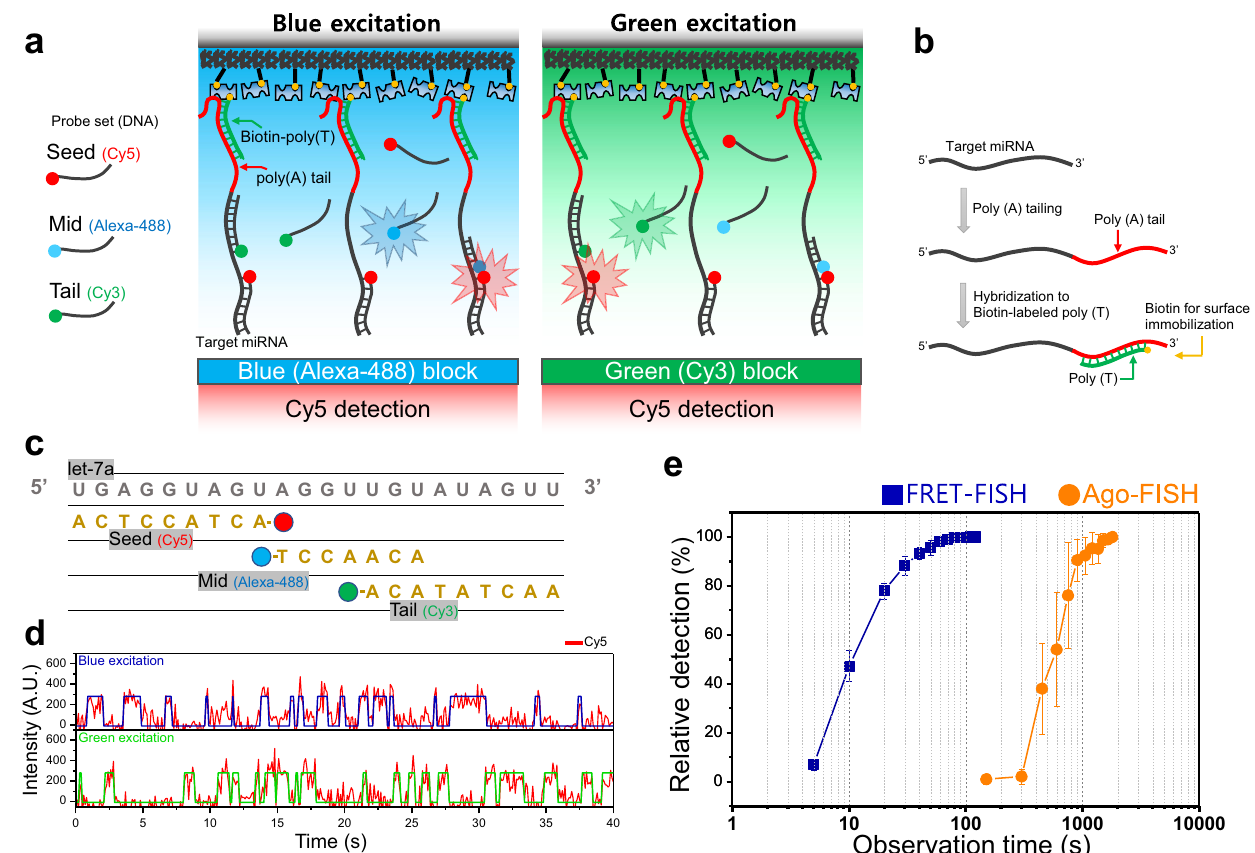
Fig. 1 miRNA detection using dynamic FRET-FISH. a Scheme of target miRNA detection. Only the acceptor signal is used for miRNA detection whereas only donor fl uorophores (Alexa-488 and Cy3) are excited. In this way, background acceptor fl uorescence coming from fl oating accepter strands is reduced because the acceptor signal is generated only when both donor and acceptor strands simultaneously bind to target miRNAs. b miRNA preparation. Puri fi ed RNA is hybridized with biotinylated poly (T) after poly (A) tailing. Then RNA is immobilized on a surface via biotin-streptavidin interaction. c Sequences of the target miRNA (let-7a), Cy5-labeled seed probe, Alexa-488-labeled mid probe, and Cy3-labeled tail probe. d Representative Cy5 fl uorescence intensity time traces (red) detected at Alexa-488 excitation (top) and at Cy3 excitation (bottom). The blue and green traces represent the results of hidden Markov modeling of acceptor signals at Alexa-488 and Cy3 excitations, respectively. e Observation time dependency of the let-7a number detected using dynamic FRET-FISH (blue) and Ago-FISH (orange). In dynamic FRET-FISH, we identi fi ed as a proper target miRNA if a molecule exhibited an acceptor (Cy5) fl uorescence signal at both Alexa-488 and Cy3 excitations during the designated observation time. In Ago-FISH, 5% duty cycle of the three DNA probes was used as a threshold for target identi fi cation 6 . The duty cycle is de fi ned as the fraction of the total observation time in which a probe was binding to the target miRNA. For dynamic FRET-FISH, 1200 nM donor and 40 nM acceptor probes were used. For Ago-FISH, 2 nM probes were